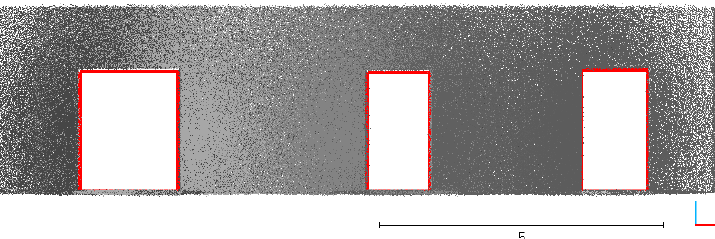
Figure 10. Hollow areas on the wall that were extracted as doors. Extracted areas are within red rectangles.